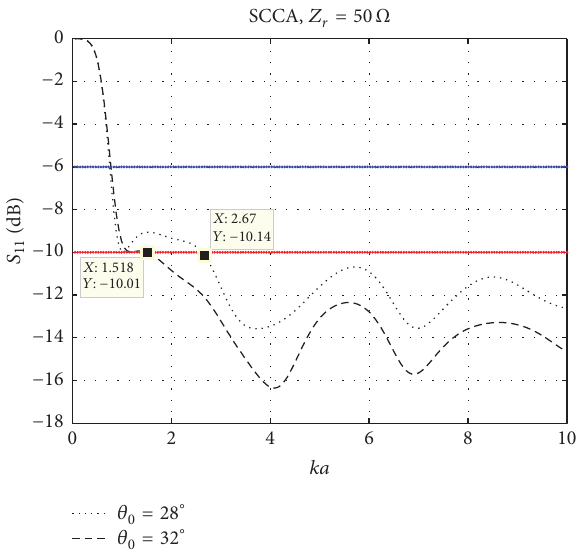
Figure 6: 𝑆 11 of the theoretical SCCA example versus 𝑘𝑎 for 𝜃 0 = 28 ∘ and 32 ∘ for 𝑍 𝑟 = 50 Ω .